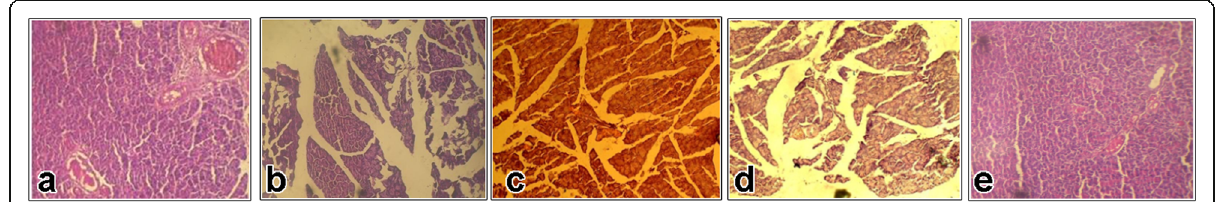
Fig. 2 Representative images for histopathological evaluation of pancreas of Wistar albino rats subjected to STZ-induced diabetic model at × 100 magnification. a Normal control group. b Diabetic control. c HAEGL (250 mg/kg). d HAEGL (500 mg/kg). e Standard